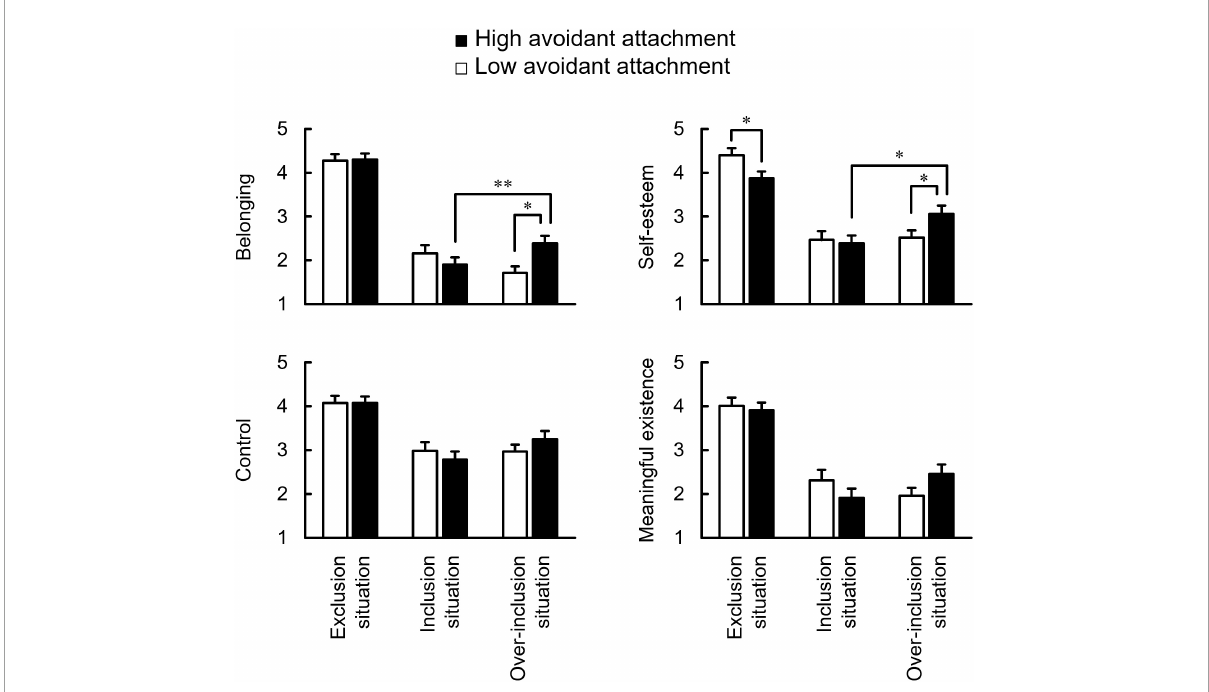
FIGURE2 Comparison between the low and high avoidant attachment of need-threat score for belonging, self-esteem, control, and meaningful existence in three situations. Error bars indicate the standard error of means across participants. ∗ p < 0.05, ∗∗ p <